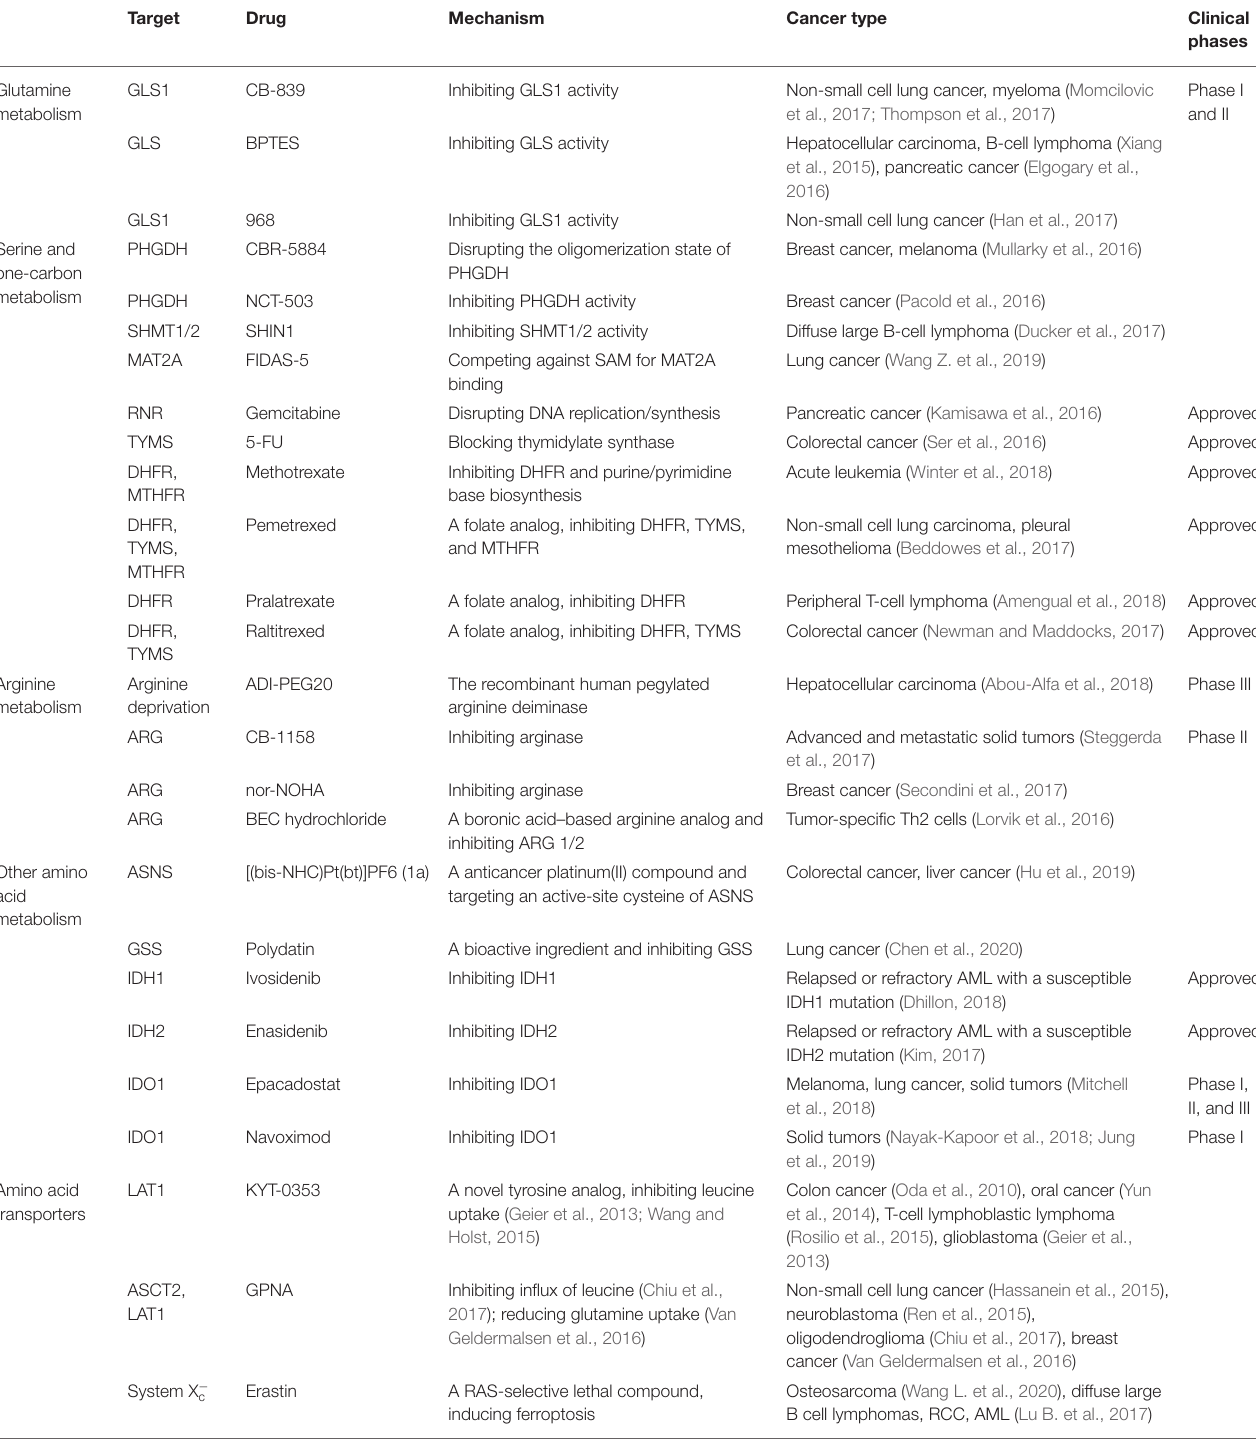
TABLE 1 | Key enzymes/transporters and their drugs in cancer amino acid